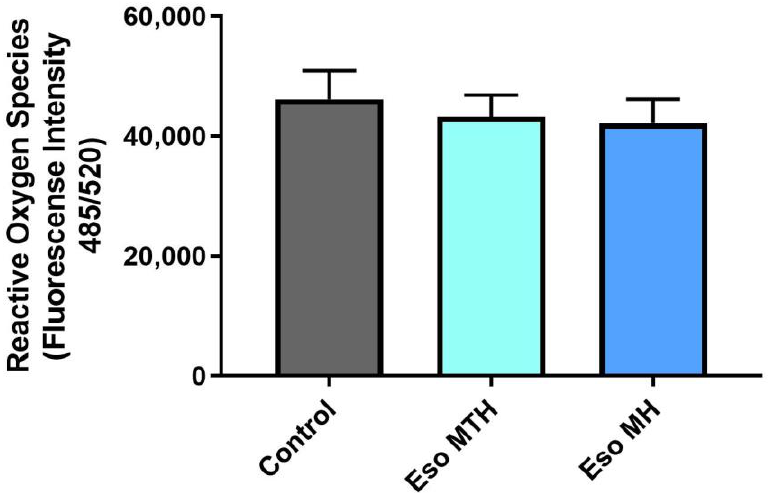
Figure 3. Reactive oxygen species production induced by sodium azide (Na Azide) was not al- tered with treatment of either esomeprazole magnesium hydration isomer. Reactive oxygen spe- cies production induced by Na Azide (control) was not significantly altered by treatment with esomeprazole magnesium trihydrate (Eso MTH) or esomeprazole magnesium hydrate (Eso MH). Eso MH and Eso MTH were administered at 100 μmol/L. Data expressed as mean ± SEM ( n =